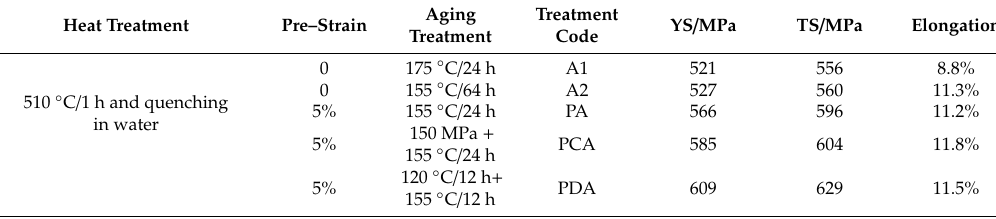
Table 2. Aging treatment procedures and mechanical properties of the Al–Cu–Li